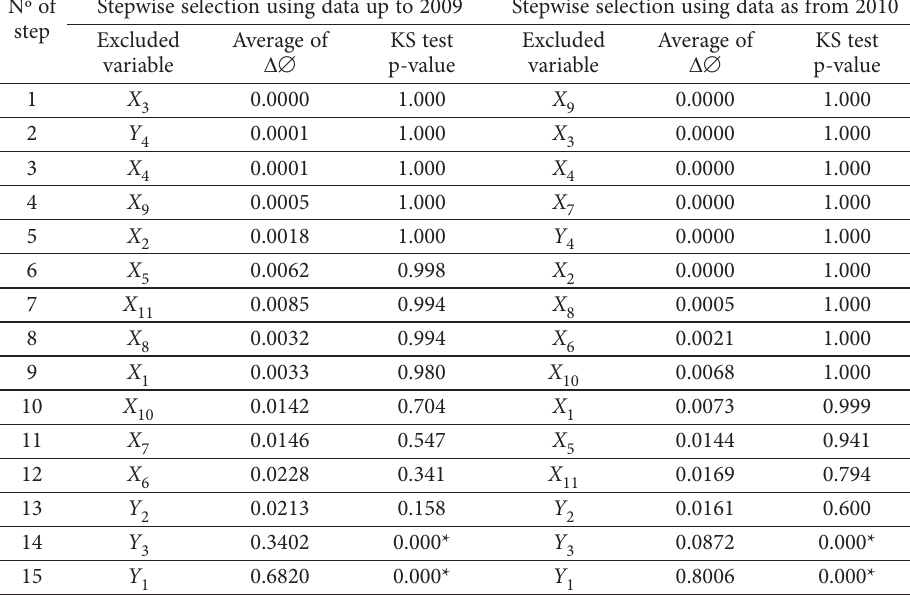
Table 8. Comparison of the stepwise selection before and after the adoption of full IFRS in Brazil Nº of